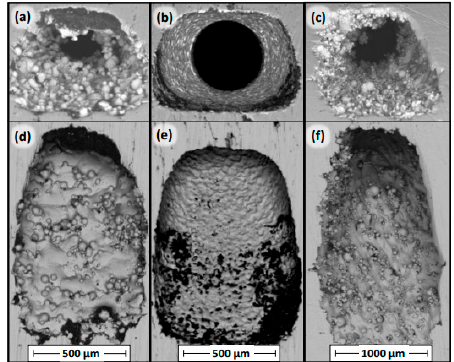
Figure 21. Microscopic surface roughness images of film cooling holes and innovative configura- tions ( a ) 7-7-7, ( b ) console, ( c ) crescent, ( d ) oscillator, ( e ) spiral and, ( f) tripod [125]. More discussions are available in [121] .